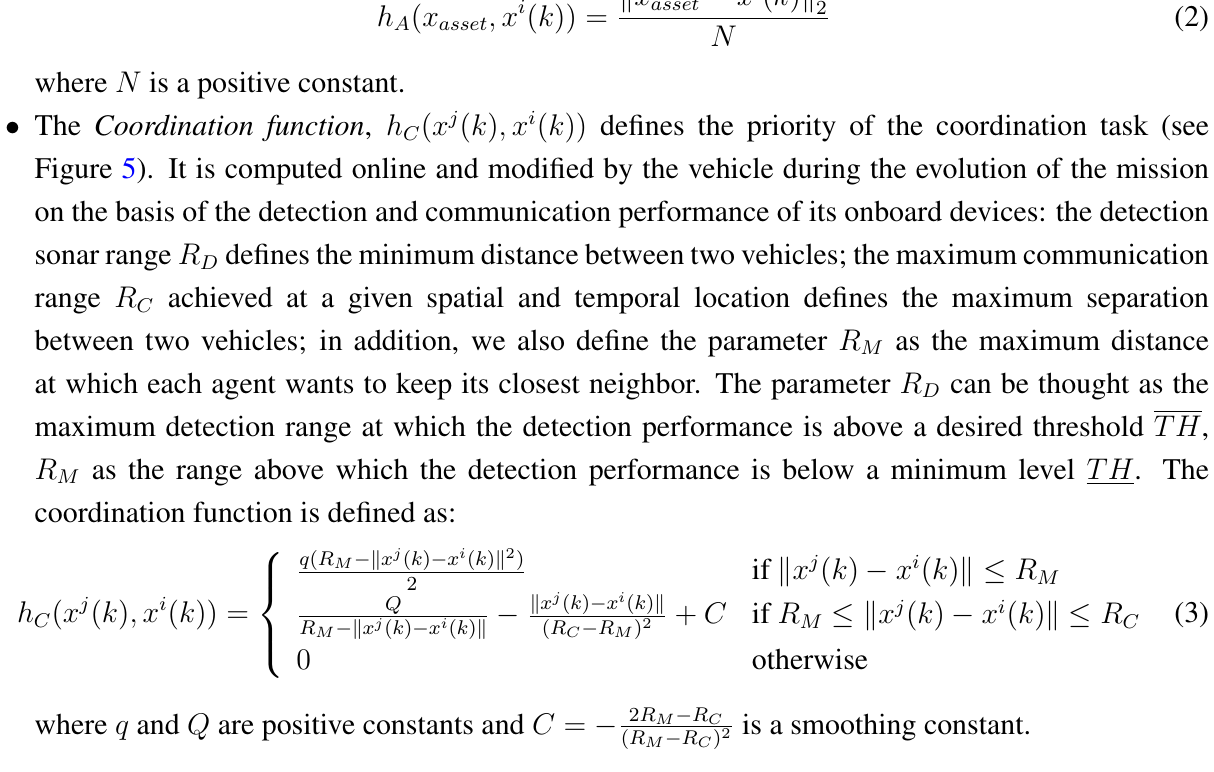
The function represents the